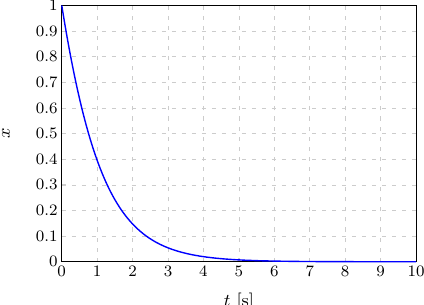
Figure 1. Time dependence of the state variable (Example 4.1).